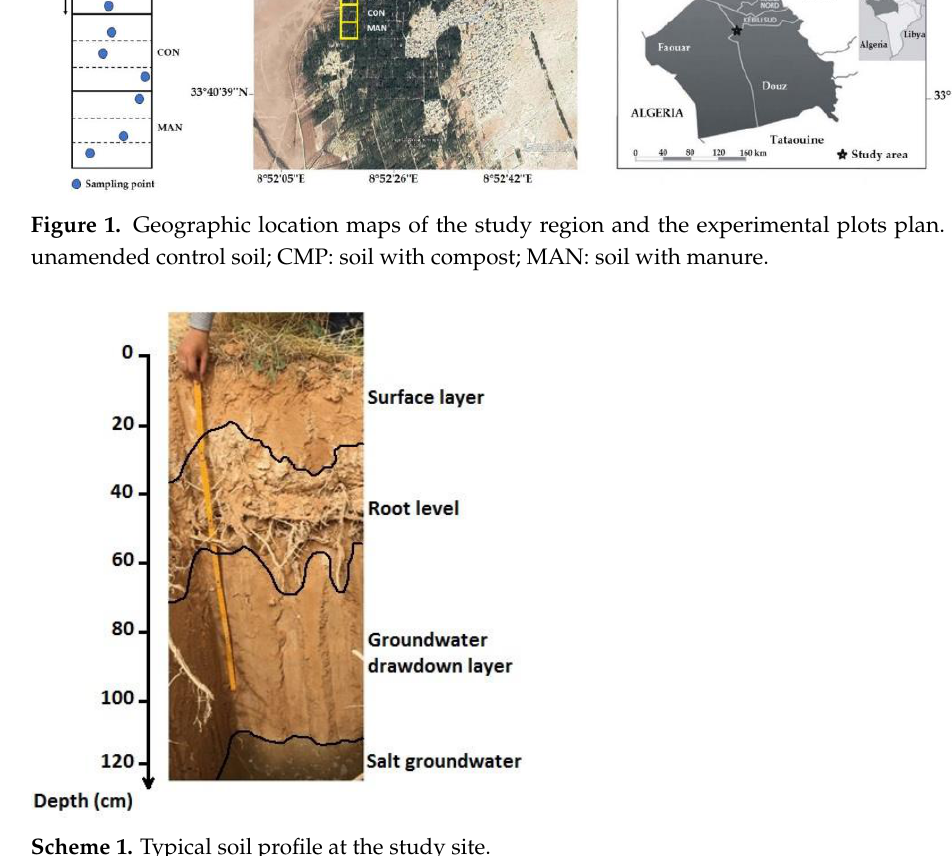
Scheme 1. Typical soil profile at the study site.